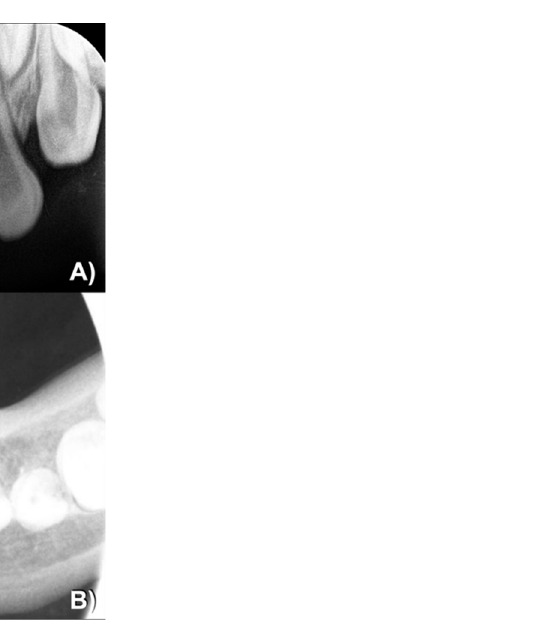
Figure 2. ( A ) Patient 1. Mesiodens (arrow). Torus palatinus (arrowhead). ( B ) Patient 1. Periapical radiograph showing an unerupted mesiodens (arrow). ( C ) Patient 2. Extracted double mesiodens. ( D ) Patient 3. Periapical radiograph showing an unerupted mesiodens (arrow).